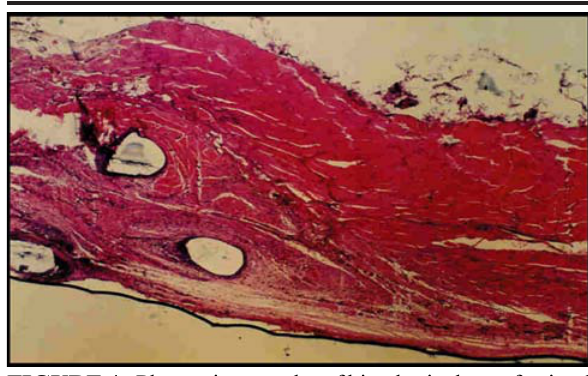
FIGURE 4 - Photomicrography of histological cut of animal in cohort E-B (10x magnification), showing the site of the junction between muscle and newformed fibrous tissue. H.E. staining